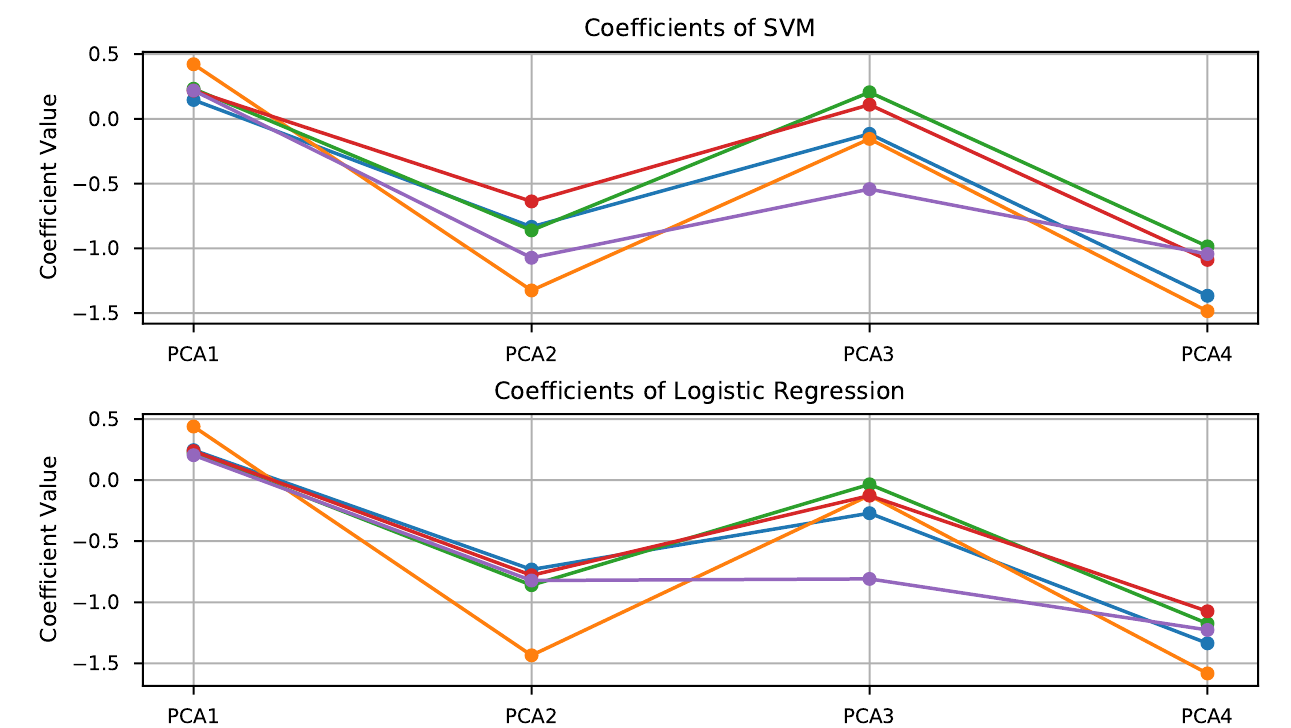
Figure 8. Visualization of the coefficients associated with each PCA component for the Support Vector Machine (upper panel) and Logistic Regression (lower